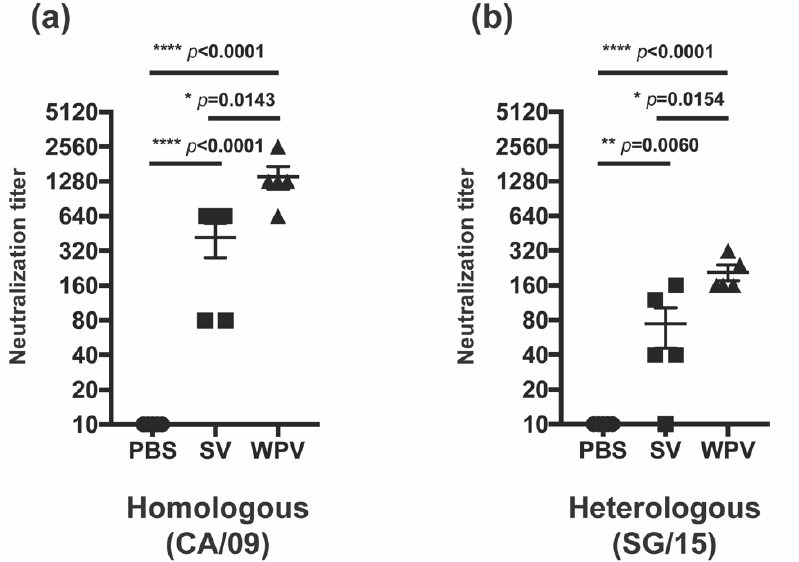
Figure 4. Neutralizing antibody titers after vaccination with WPV and SV. C57BL/6 mice were subcutaneously vaccinated twice at 3-week intervals with 9 µg of protein of monovalent CA/09 WPV or SV, as shown in Figure 1a. Serum samples collected on day 41 were evaluated for neutralizing antibody titers against CA/09 ( a ) and SG/15 ( b ). The circles, squares, and triangles indicate data from mice inoculated with PBS, SV, and WPV, respectively. * p < 0.05, ** p < 0.01, **** p < 0.0001, one-way ANOVA using a multiple-comparison correction.